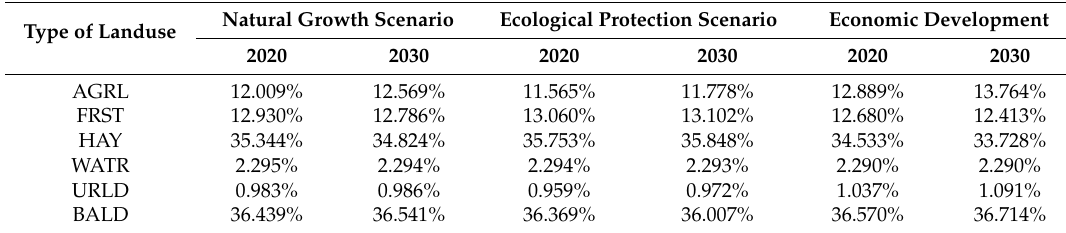
Table 13. Area ratio of different land use